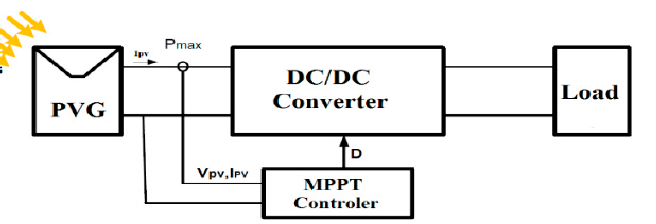
Figure 1. Adaptation block as a power interface between a photovoltaic generator(PVG) and load, to transfer the maximum power.